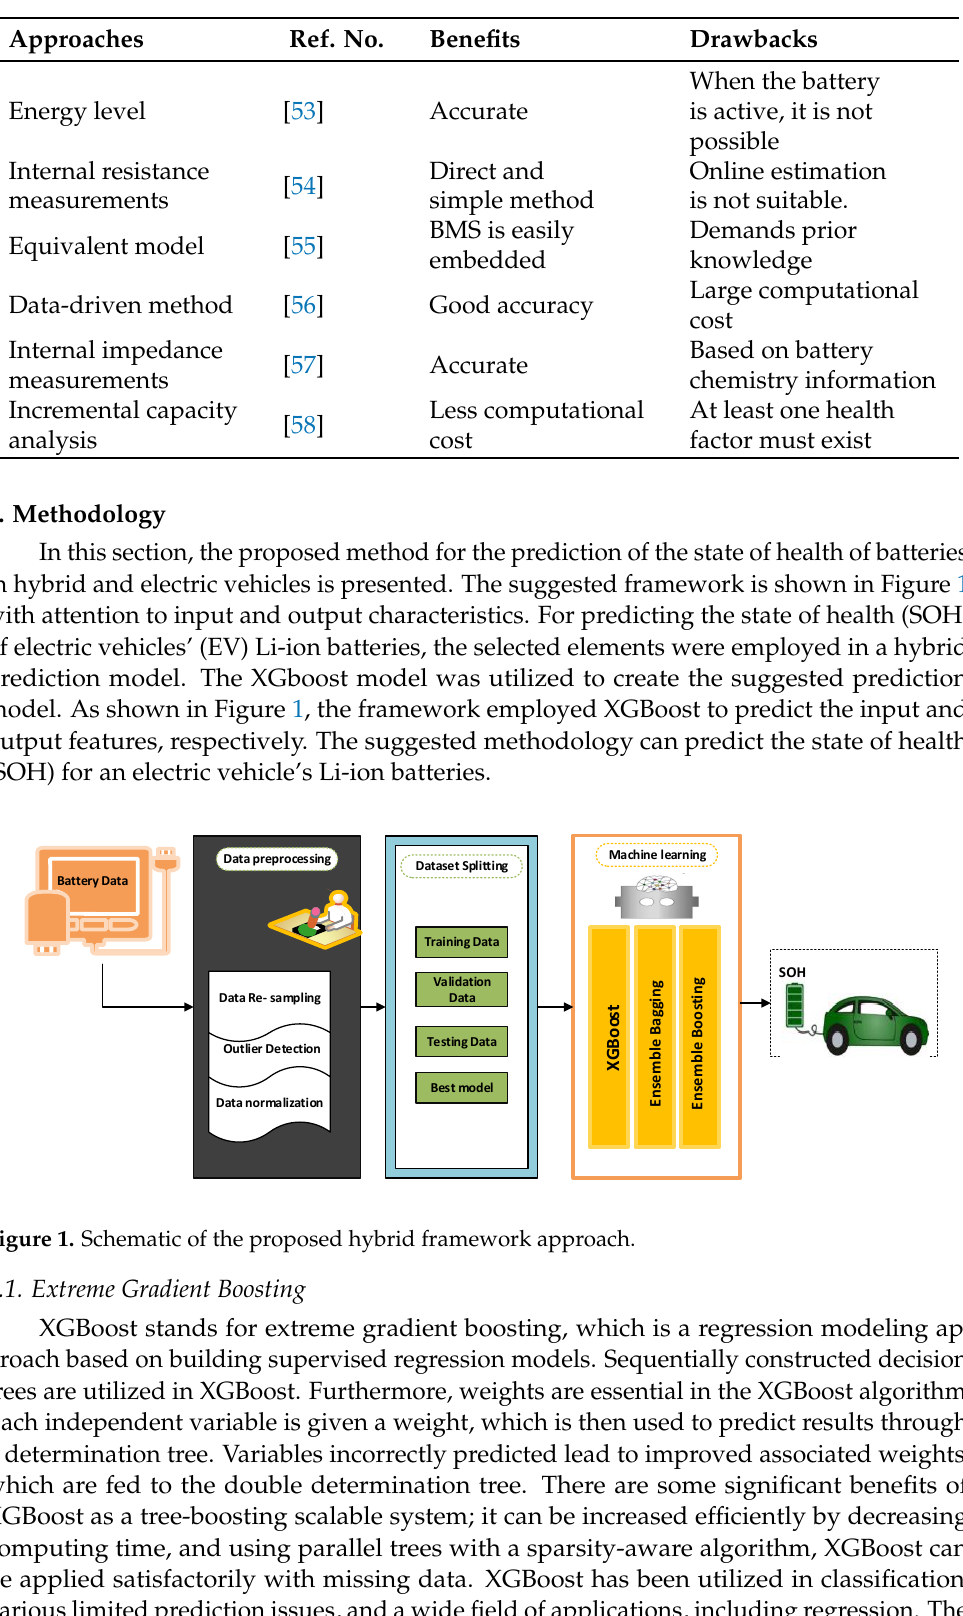
Table 1. Experimental of related review papers.